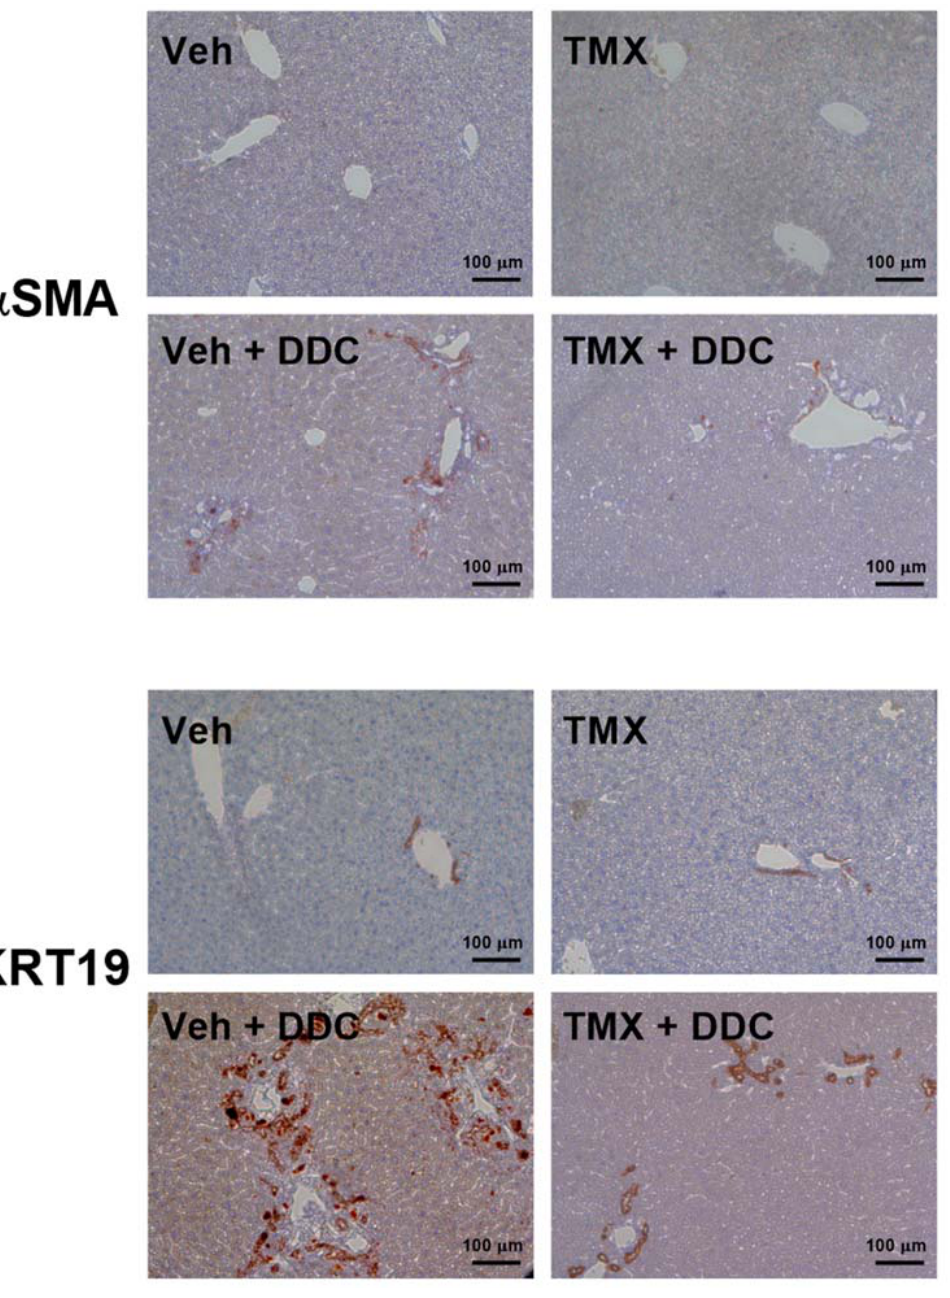
Figure 3. Tamoxifen treatment decreases protein expression of α SMA and KRT19. Mice were fed standard or DDC-supplemented diet, and treated with tamoxifen or vehicle, as indicated. Liver sections were first incubated with anti- α SMA or anti-KRT19 antibody as indicated, and then incubated with HRP-conjugated secondary antibody and stained with diaminobenzidine (DAB). Standard diet-fed mice had low expression of α SMA and KRT19 regardless of treatment. DDC-feeding increased expression of α SMA and KRT19 in vehicle-treated mice, as shown by brown staining and tamoxifen treatment significantly reduced this increase. Sections are from male mice, and the same pattern was obtained in female mice (not shown). The anti-keratin antibody stains both keratin 17 and keratin 19, but in liver, keratin 19 is predominant. α SMA—alpha smooth muscle actin, Krt19—keratin 19, TMX—tamoxifen,